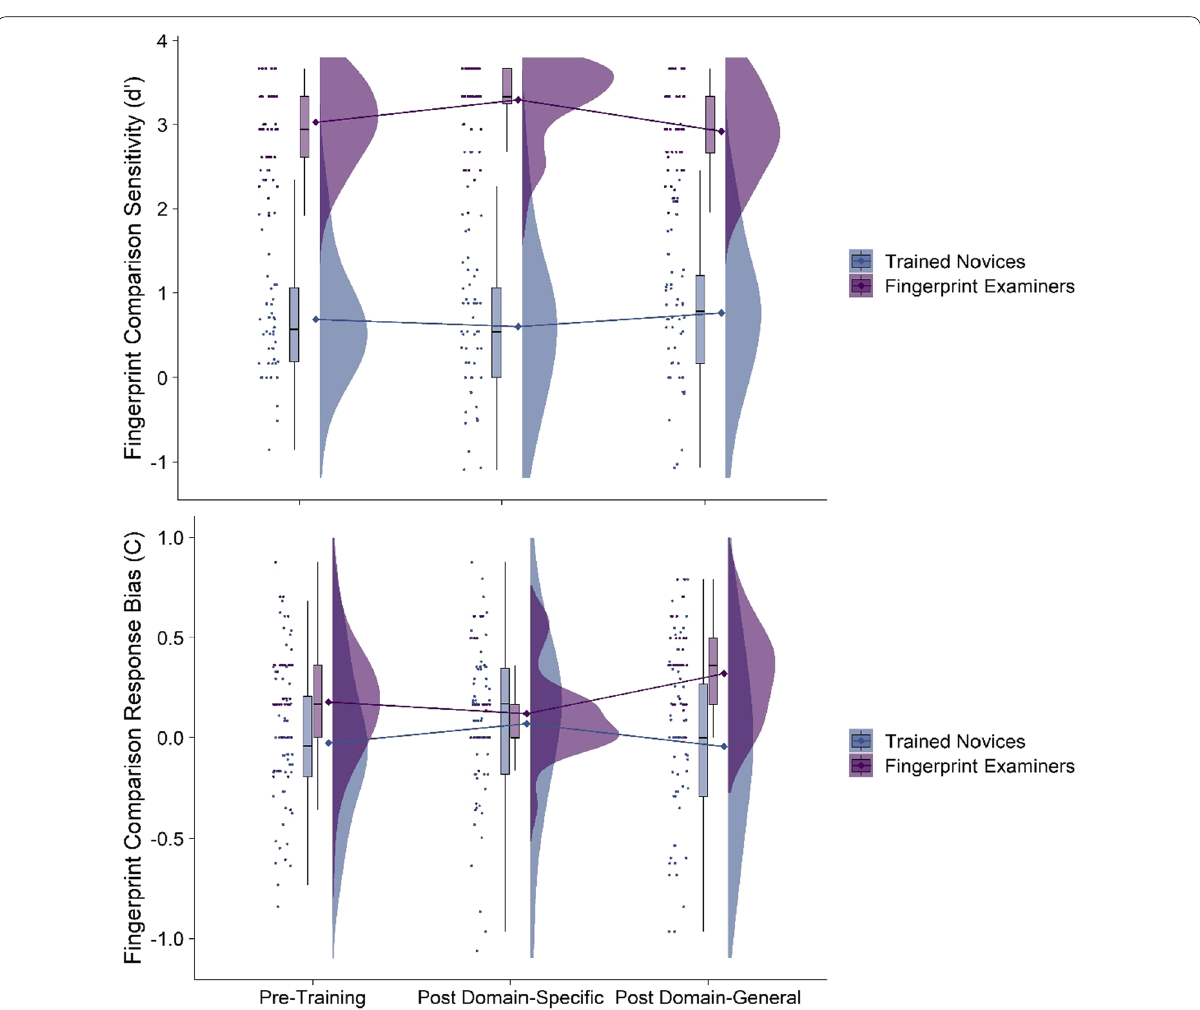
Fig. 8 Sensitivity (upper panel) and response bias (lower panel) in the fingerprint comparison task by time and group in Experiment 3. Raincloud plots depict (left-to-right) the jittered participants’ averaged data points, box-and-whisker plots, means (represented by diamonds) with error bars representing 1 SE, and frequency ±